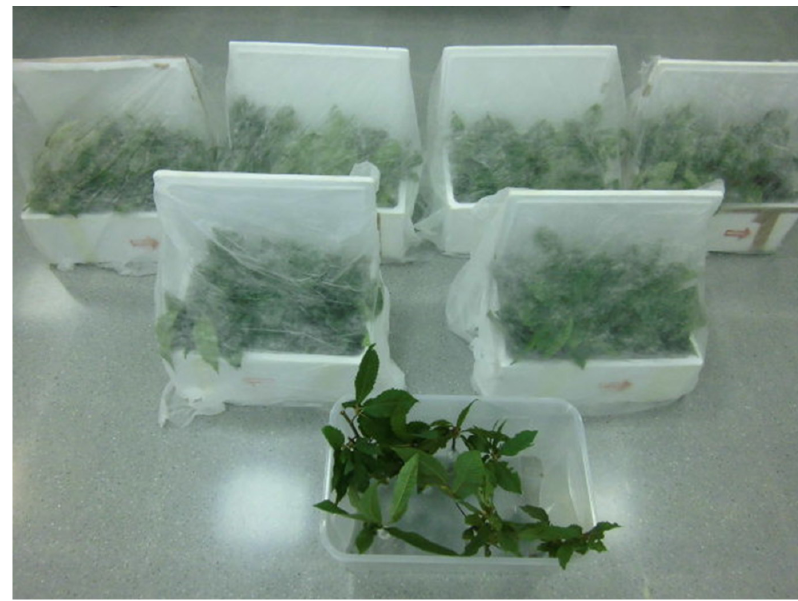
Figure 1. Receipt of the first shipment of infested chestnut branches.